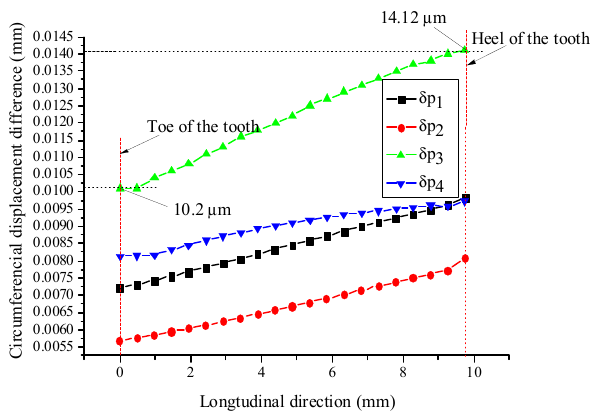
Figure 5. The circumferential displacement difference curves at positions P 1 , P 2 , P 3 and P 4 . As shown in Figure 5, the circumferential displacement differences increase gradually from the toe of the tooth to the heel of the tooth and reach the maximum at the heel of the tooth. It can be also seen that the circumferential displacement differences reach the maximum at the critical position P 3 which is the final point of single pair contact. In other words, the comprehensive deformation of the tooth is biggest at P 3 because one tooth bears all load and the bending torque is great. These circumferential displacement difference curves provide a significant basis for